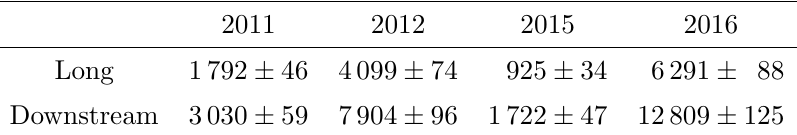
Table 2 . Signal yields in the long and downstream categories of the 2011, 2012, 2015 and 2016 data